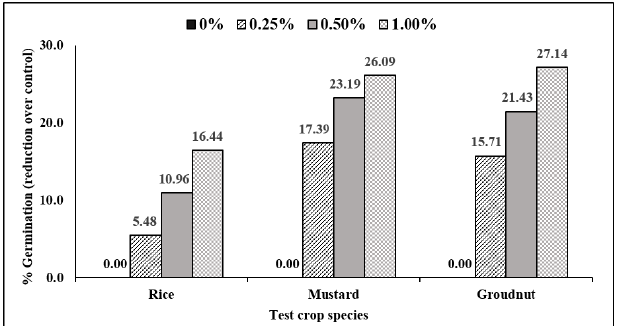
Figure 2: Effect of different concentrations of Siam weed debris on reduction over control of germination of test crop species Table 2: Effect of different concentrations of Siam weed debris on reduction over control of growth of rice, mustard and groundnut Test crop